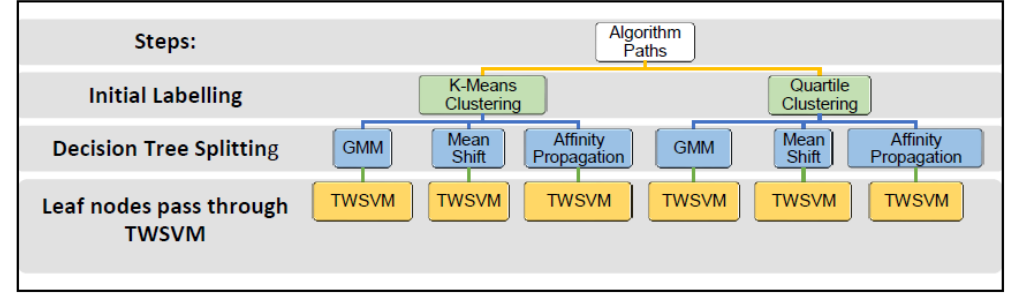
Figure 1. Graphical representation of our proposed algorithm.